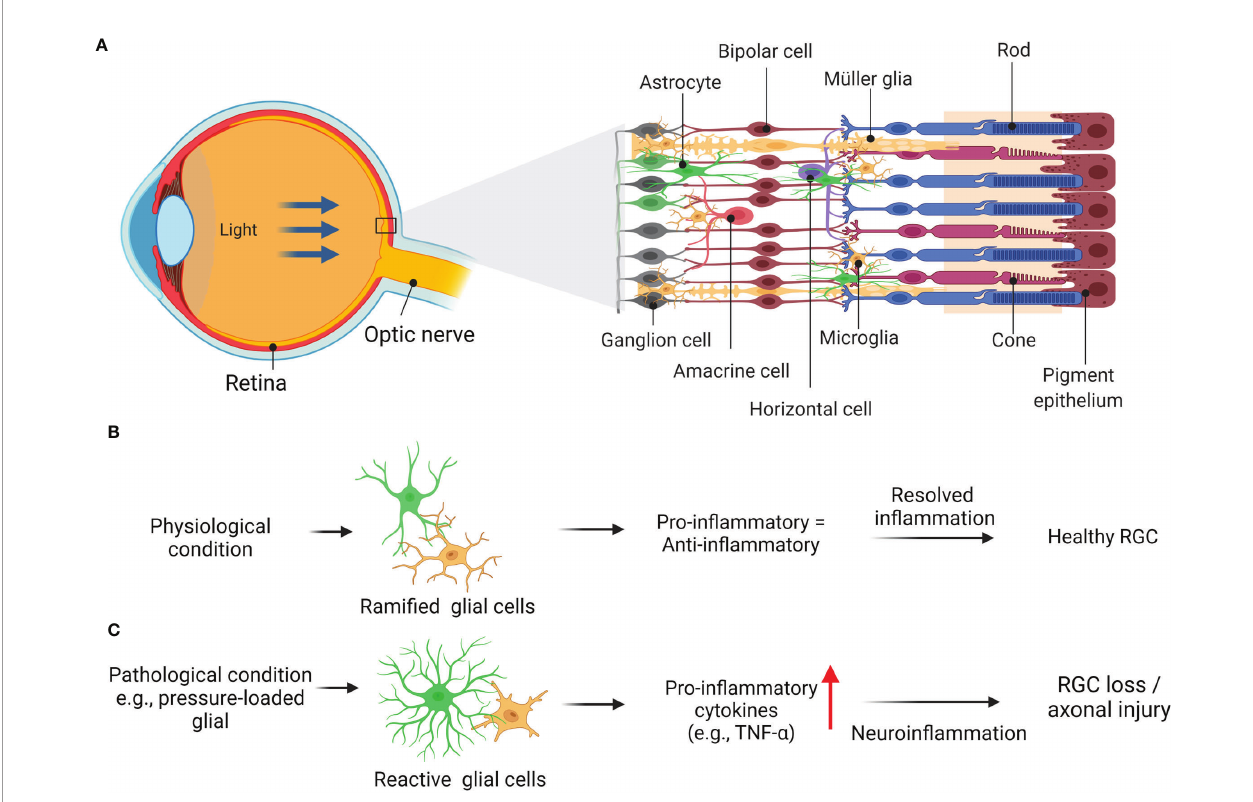
FIGURE 2 | Schematic diagram showing basic anatomy of eye (A) with retinal layers and glia-driven in fl ammation in healthy retina (B) . Glaucoma related insult e.g., pressure-loaded glial, generated and expressed by retinal glial cells, promotes neurotoxicity to RGCs and their axonal loss (C) . Adapted from “ Structure of The Retina ” by BioRender.com (2022). Retrieved from